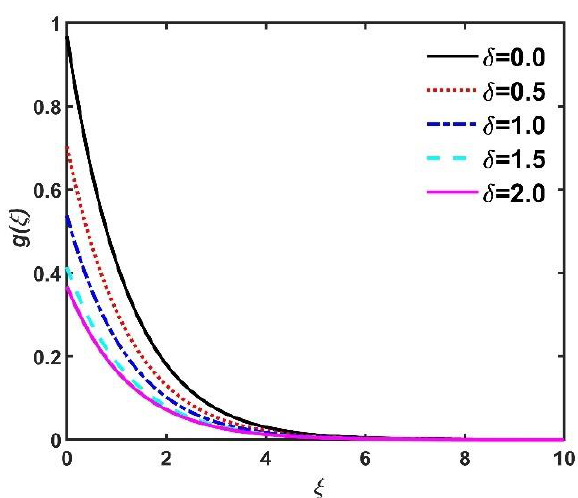
Figure 17. Impact of 𝛿 on 𝑔(𝜉) .